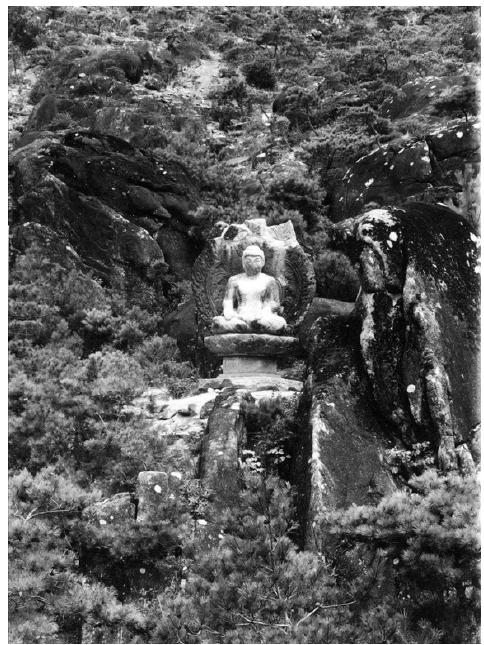
Figure 5. Seated Buddha. Samn ŭ nggye valley on Mount Nam. 8–9th century, Unified Silla. Gelatin dry plate from the colonial period. Courtesy of National Museum of Korea.